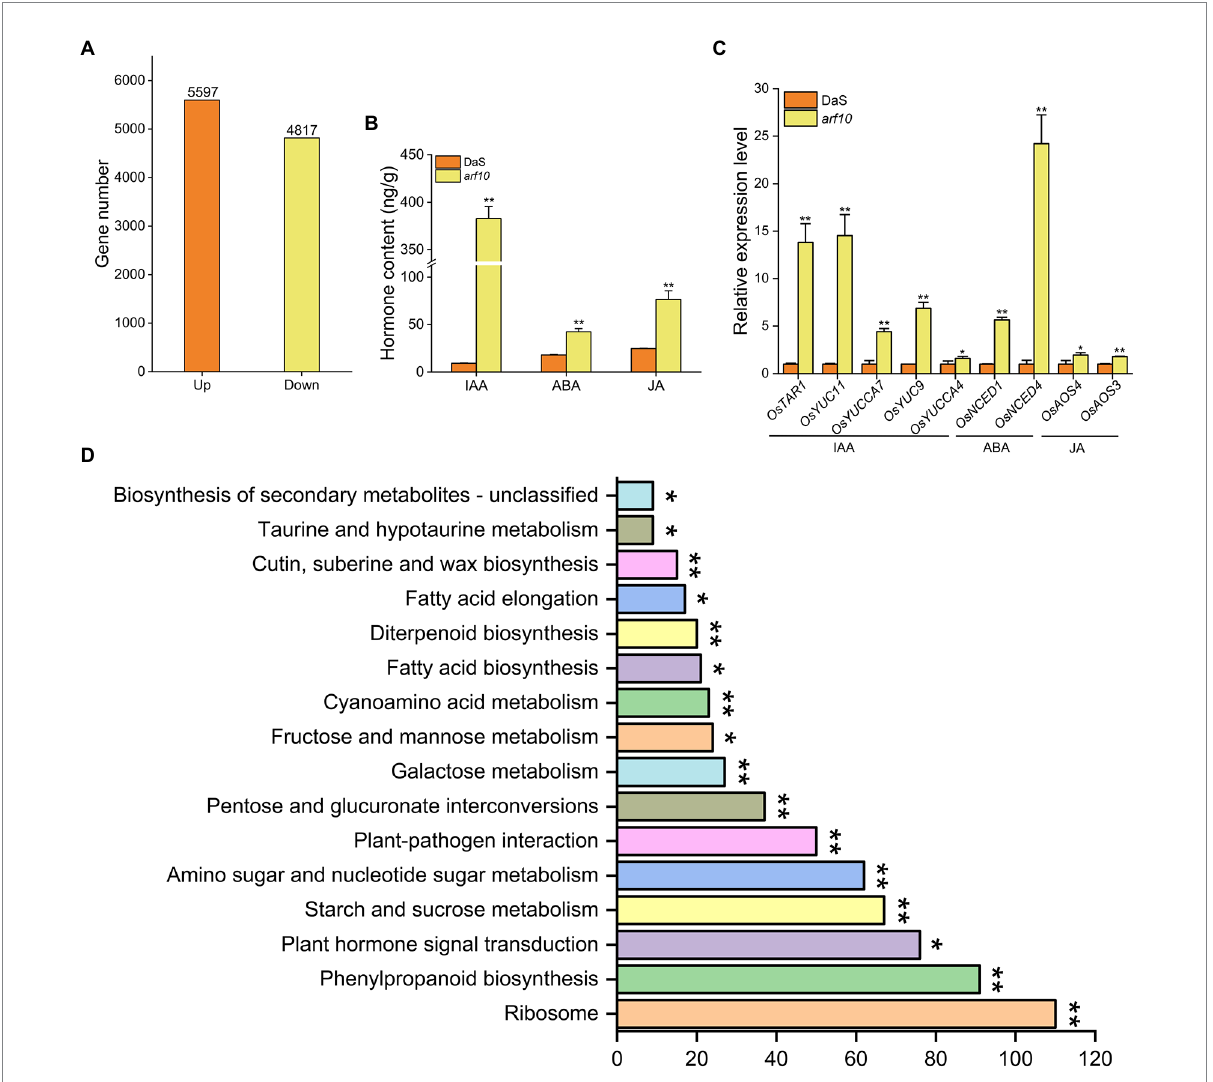
FIGURE 6 Transcriptome analysis of knockout lines arf10 and DaS. (A) Number of up- and down-regulated genes (padj <0.05) in young panicle at the pre- heading stage of arf10 compared with DaS. (B) KEGG pathway enrichment analysis of DEGs. (C) Contents of auxin, abscisic acid, and jasmonic acid in arf10 and DaS at the pre-heading stage. (D) Relative expression of auxin, abscisic acid, and jasmonic acid synthesis genes of arf10 and DaS at the pre-heading stage. The data represent the mean values ± SD ( n = 3), * p ≤ 0.05 and ** p ≤